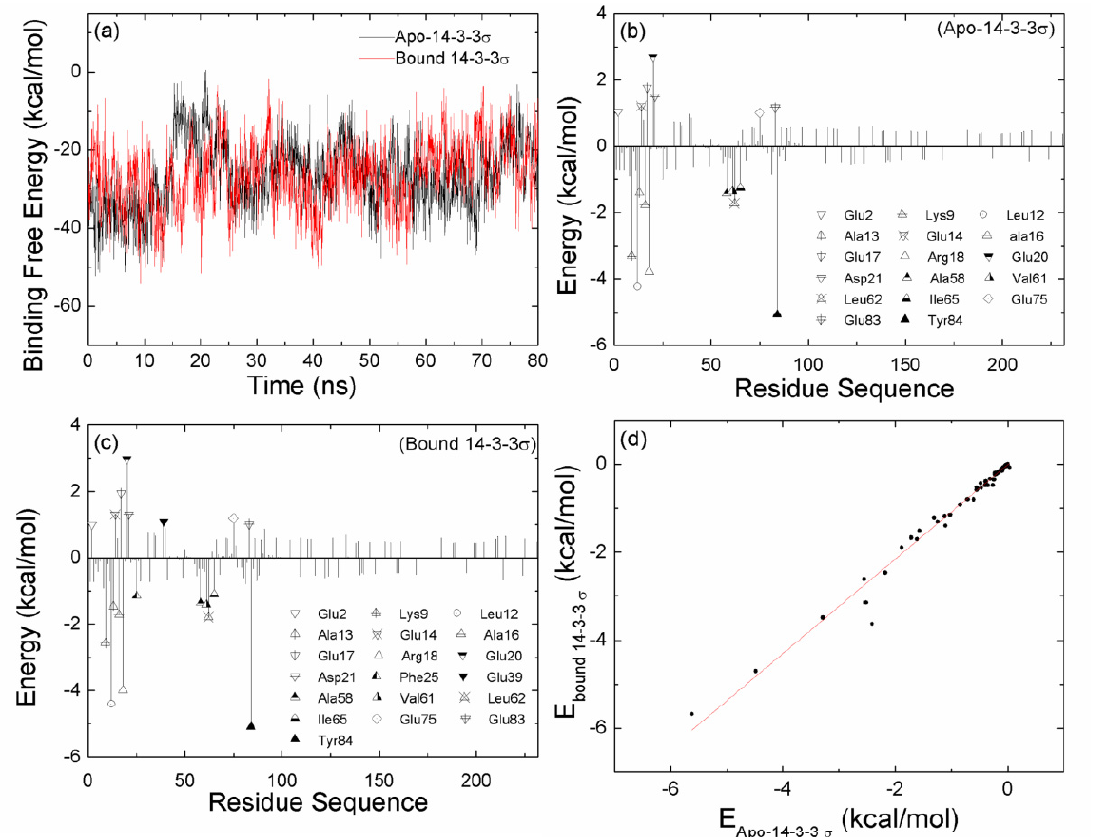
Figure 4. ( a ) Binding free energies calculated for 2000 snapshots extracted at 40 ps intervals from the whole MD simulations for apo-14-3-3 σ and bound 14-3-3 σ ; ( b ) Decomposition of energy on a per-residue basis into contributions from van der Waals energy ( E electrostatic energies and polar component of solvation free energy ( E ) component of solvation free energy for residues of apo-14-3-3 σ , as well non-polar ( G nonpol as ( c ) for bound 14-3-3 σ ; ( d ) Comparison between the hydrophobic interactions for per residue in apo-14-3-3 σ and bound 14-3-3 σ